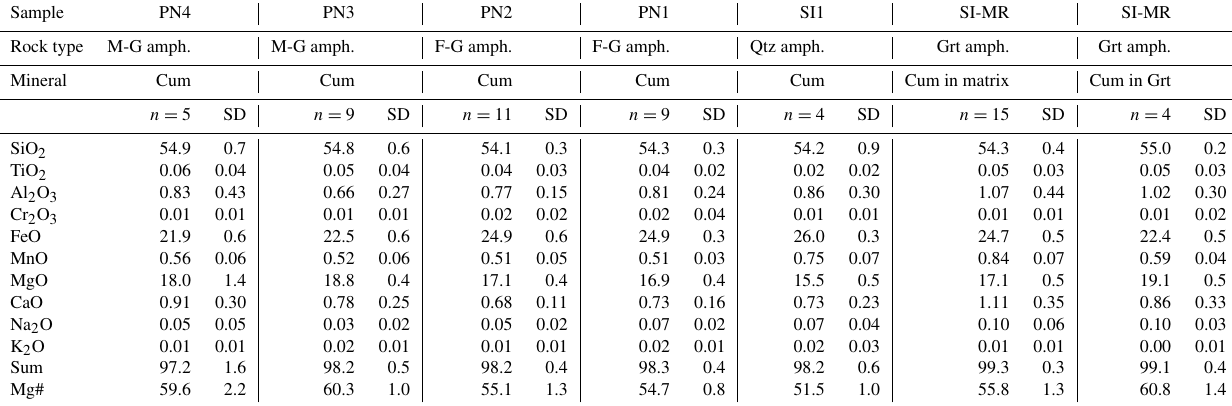
Table 3. Electron microprobe analysis of cummingtonite (average values, wt%). Sample PN4 PN3 PN2 PN1 SI1 SI-MR SI-MR Rock type M-G